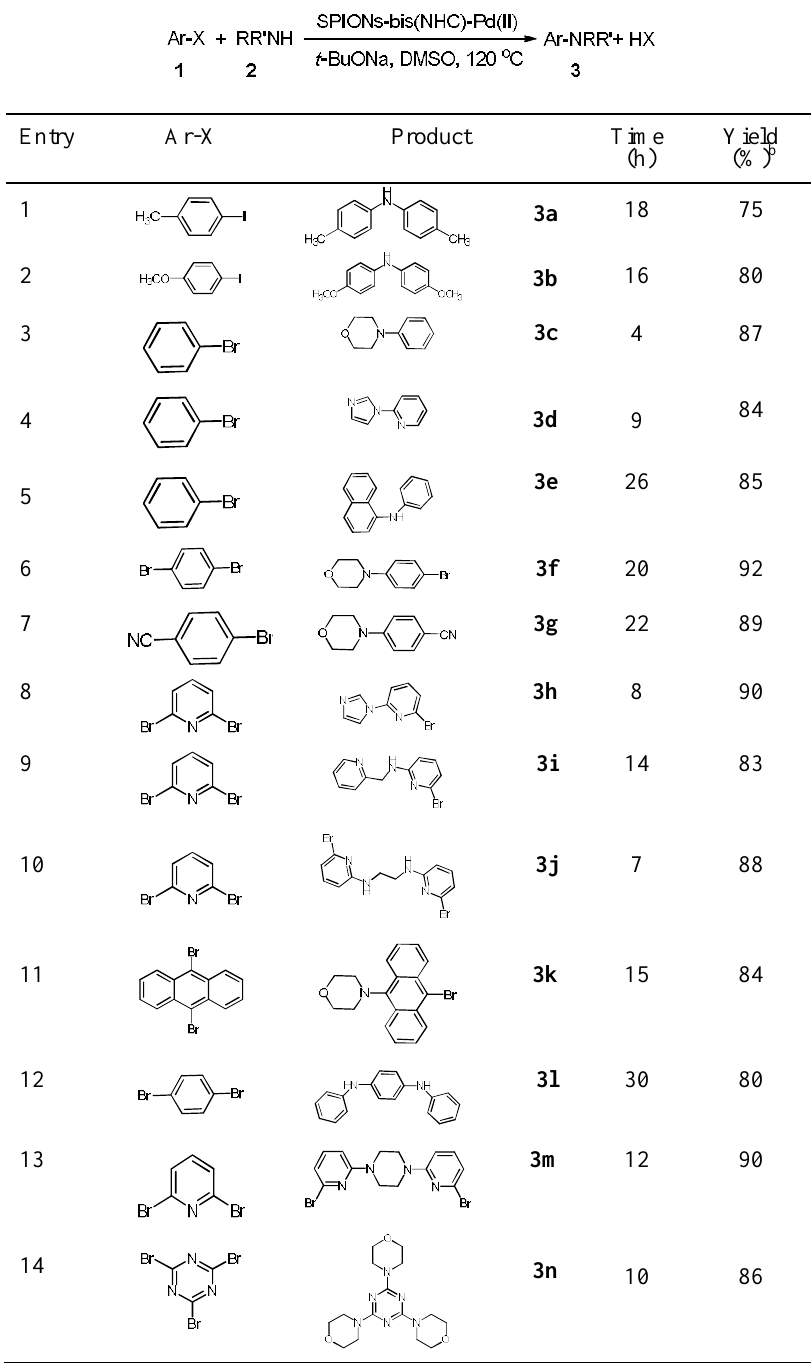
Table 2. Buchwld-Hartwig Reaction of 1 and 2 Under Conventional Heating a